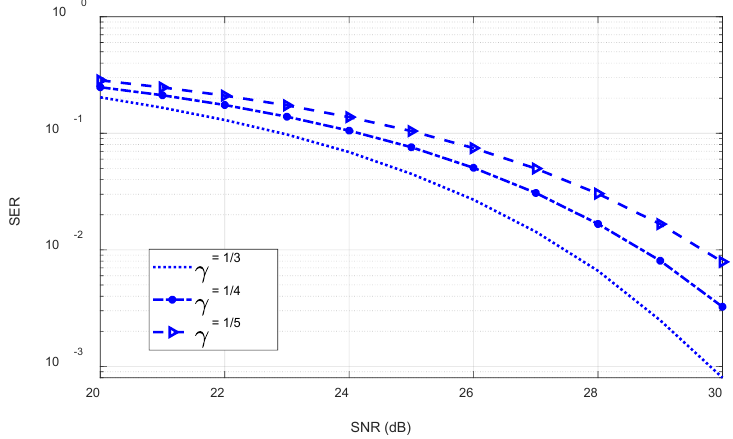
Figure 7. Error performance at different dimming levels.